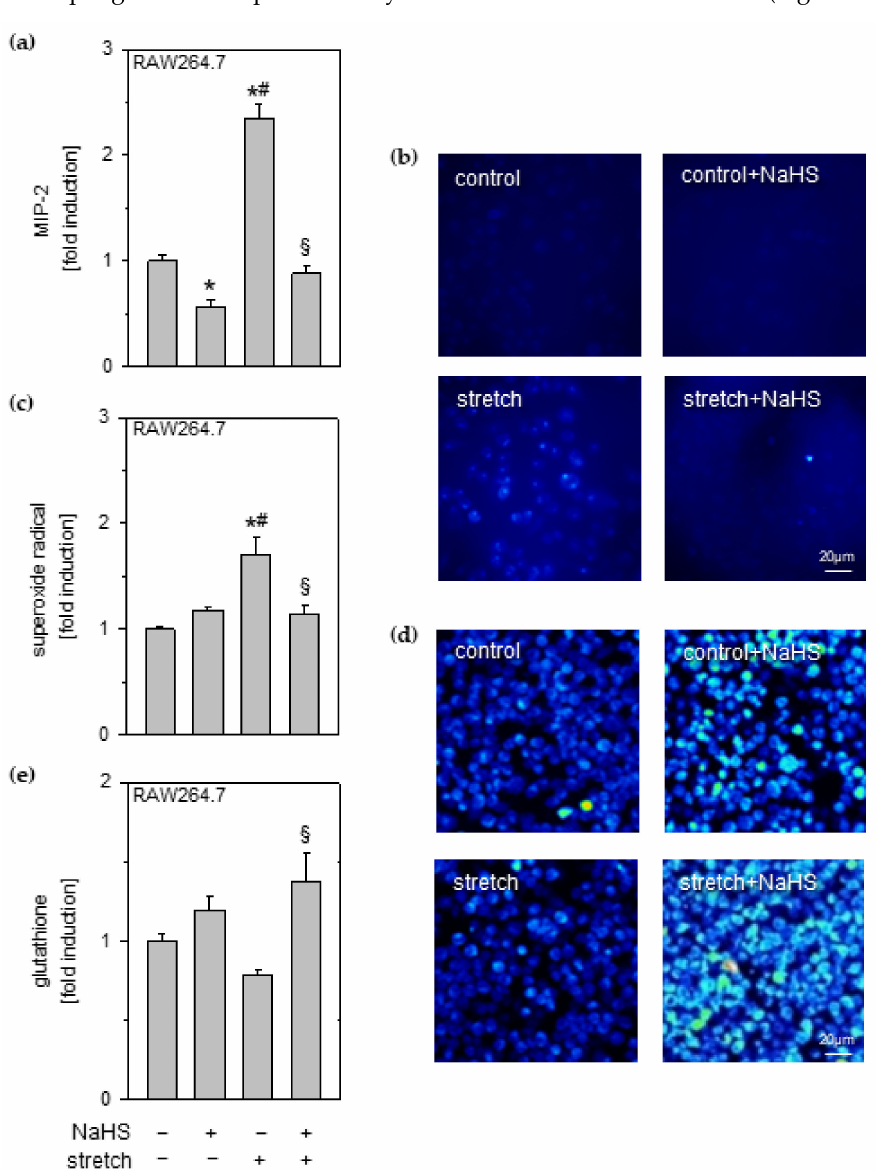
Figure 2. Effects of cyclic stretch and hydrogen sulfide on macrophages. RAW264.7 macrophage cells stretched and incubated with 1 mM NaHS, as indicated. ( a ) The amount of MIP-2 in cell medium supernatant was determined by ELISA. ( b ) Representative rainbow false-colored images of